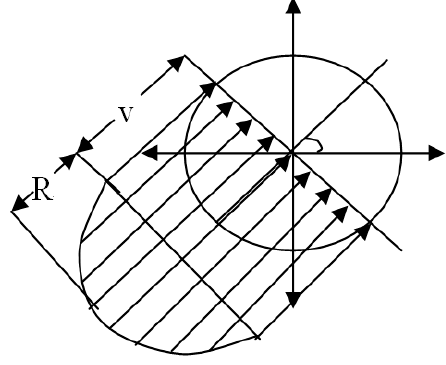
Figure 11. New expected arrival rate model.